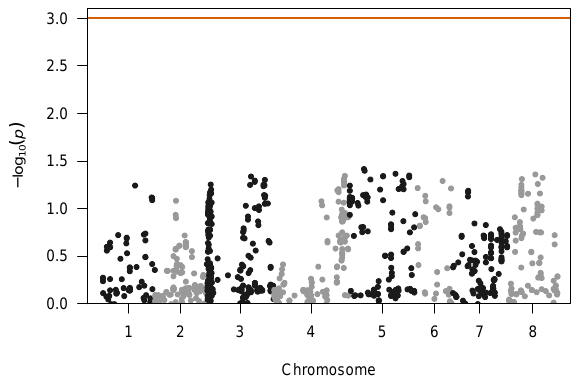
Figure 5 – Genome-scan for selection based on temporal differentiation in cape Corsica Medicago truncatula population. − log 10 ( p -value) of the simulation-based test of the null hypothesis that the locus-specific differentiation measured at each SNP is only due to genetic drift. Only SNP markers with MAF>0.05 and known position at the reference genome are shown. Red line marks p -value=0.001, the significance threshold used for figures 3 and